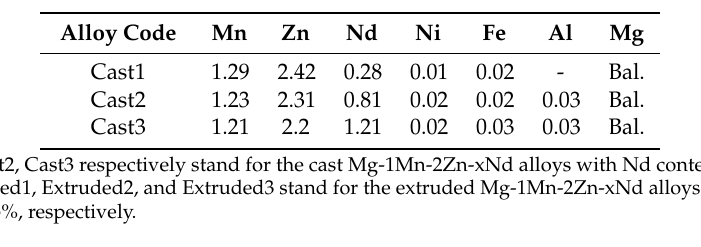
Table 1. Chemical compositions of the Mg-1Mn-2Zn-xNd alloys (mass